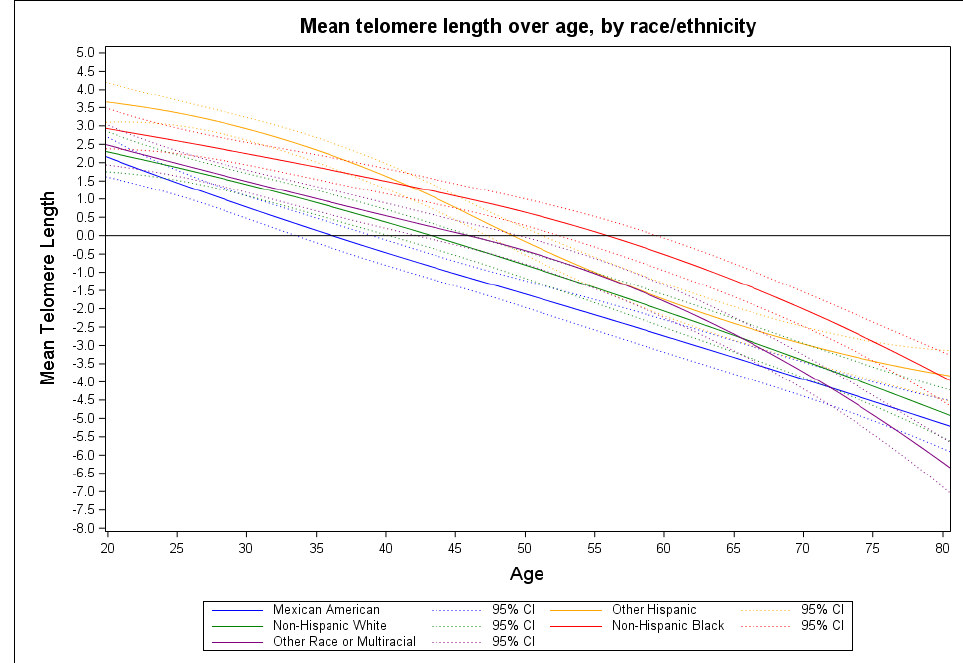
Figure 2. Mean telomere length intercept only models by race/ethnicity.